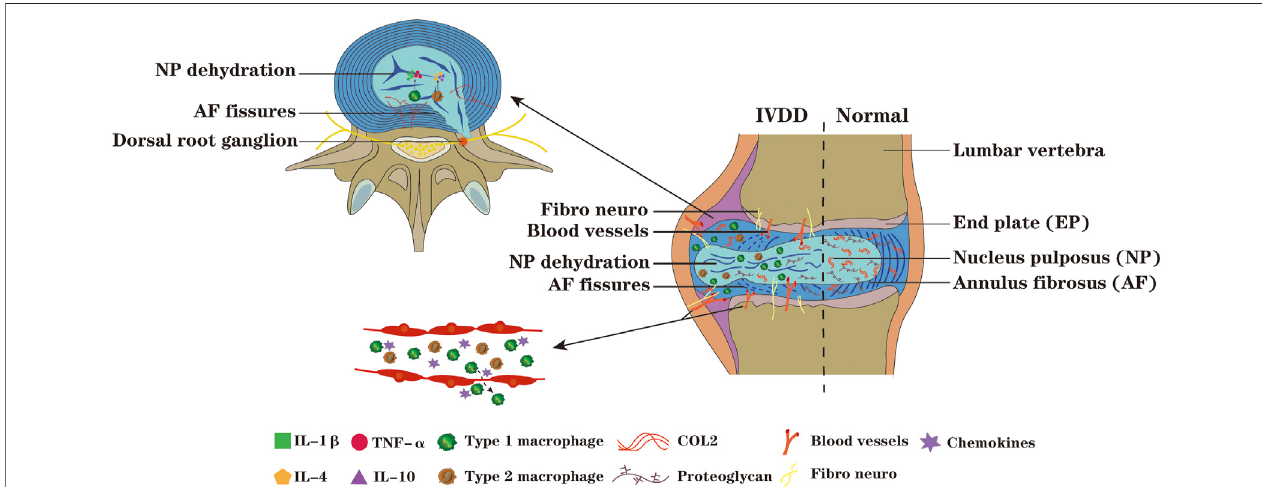
FIGURE 2 | During the process of IVDD, the NP tissue protrude along the ruptured AF, nerves and blood vessels in fi ltrate and grow into IVD,and its adjacent tissues,and chemokines recruit macrophages from peripheral tissue of IVD and peripheral blood into IVD. The macrophages M1 polarization can secrete pro- in fl ammatory factors such as IL-1 β and TNF- α , which aggravate the degeneration of IVD, while the macrophages M2 polarization can secrete anti-in fl ammatory factors such as IL-4 and IL-10. When the IVD is in a state of persistent in fl ammation, the degradation of ECM enhances; the in fl ammatory microenvironment promote the macrophages toward M1 polarization and secrete more pro-in fl ammatory factors, forming a vicious circle and inducing disc degeneration. The increased ingrowth of nerves into the IVD, and the continuous exposure of the IVD and DRG to in fl ammatory microenvironment further exacerbate IVDD.